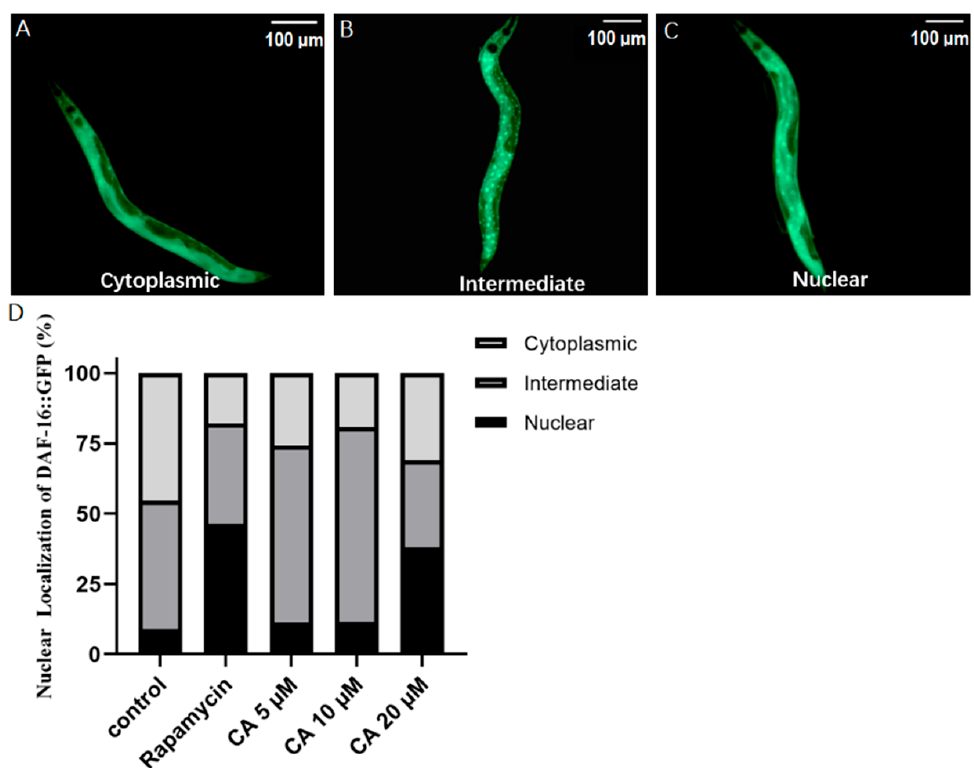
Figure 7. Effect of CA on DAF-16 localization in C. elegans . Transgenic worms harboring DAF- 16::GFP were treated with DMSO (control) or with rapamycin (1 nM) or CA (5, 10, 20 µ M) for 5 days. Representative images of DAF-16::GFP expression ( A – C ), scale bar=100 µ m. ( D ) Quantitative data of DAF-16::GFP fluorescence in different regions. Statistics of DAF-16 nucleation translocation ( n = 25 worms per group, p < 0.05).